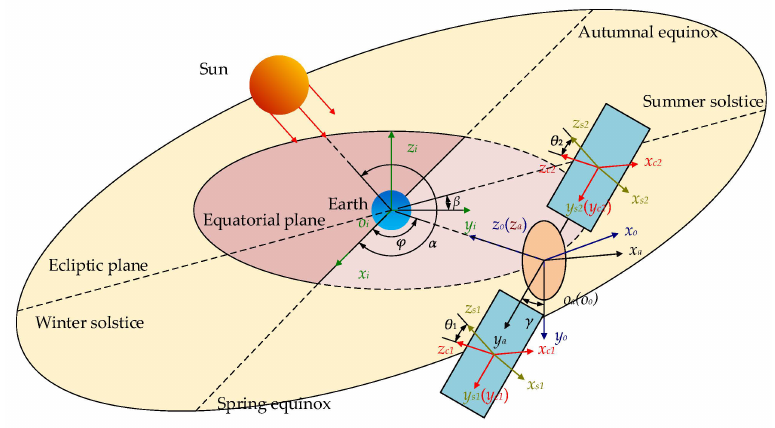
Figure 2. The definitions of the five reference